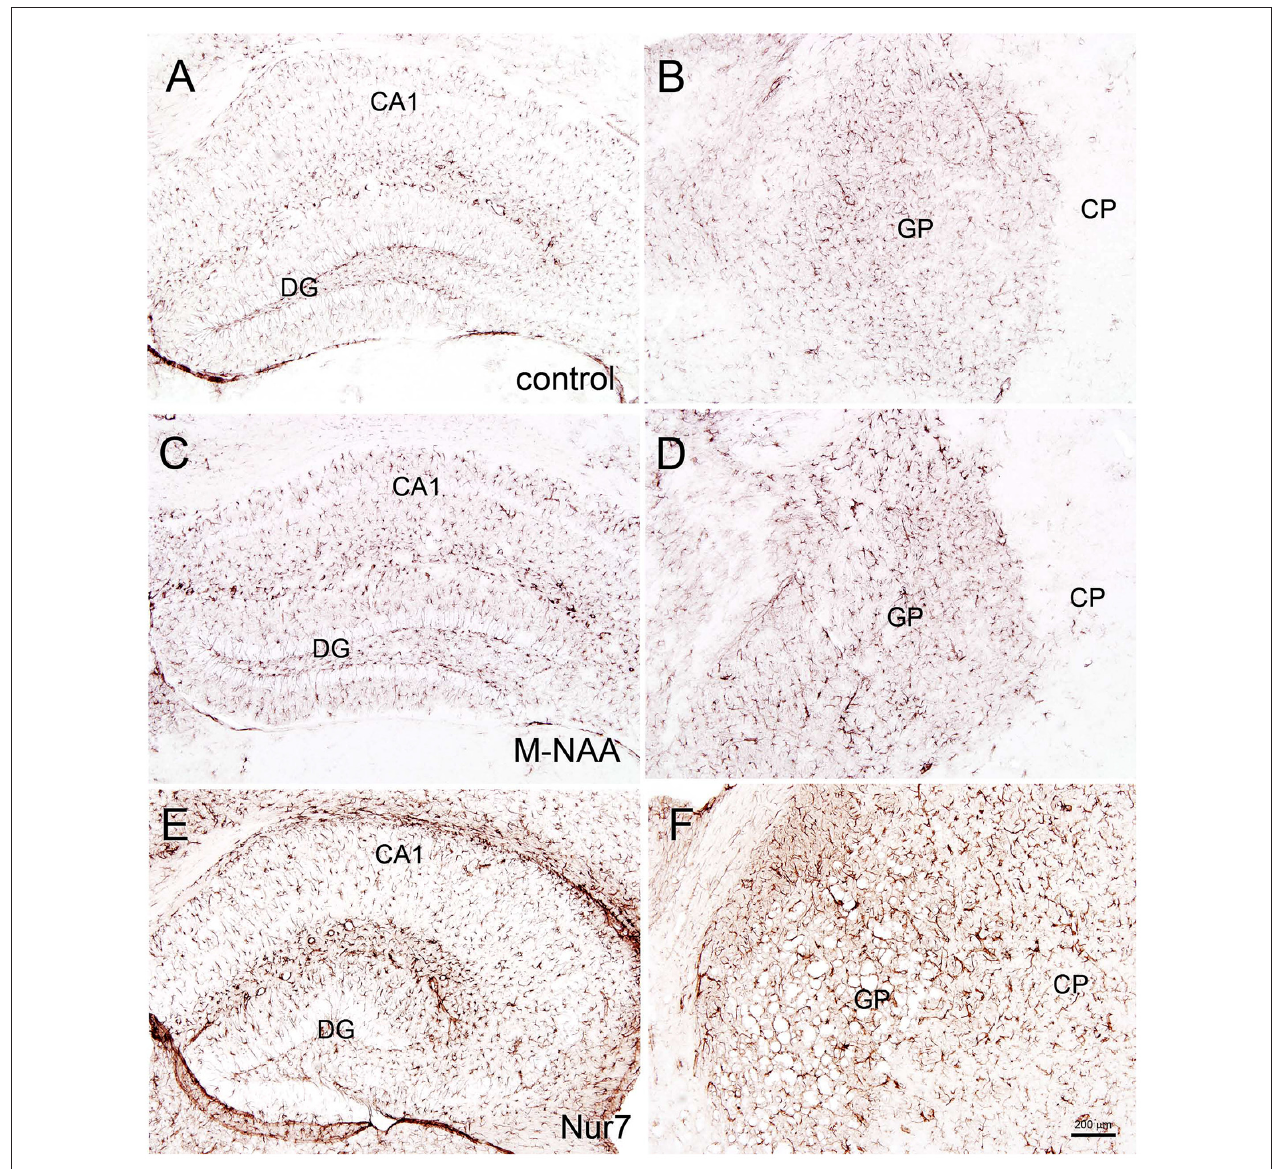
FIGURE 5 | Glial fibrillary acidic protein (GFAP) immunohistochemistry. Representative sections stained for GFAP in the hippocampus and globus pallidus (GP) of control (A,B) and treated mice. No changes in immunoreactivity were observed after 30 days of treatment with either M-NAA ( C,D ; 5 g/kg twice per day) or methanol (0.84 mg/kg twice per day; data not shown). GFAP immunoreactivity was substantially increased in Nur7 mice (E,F) . Abbreviations: CA1, CA1 pyramidal cell layer of hippocampus; DG, dentate gyrus of hippocampus; GP, globus pallidus. Micron bar = 200 µ